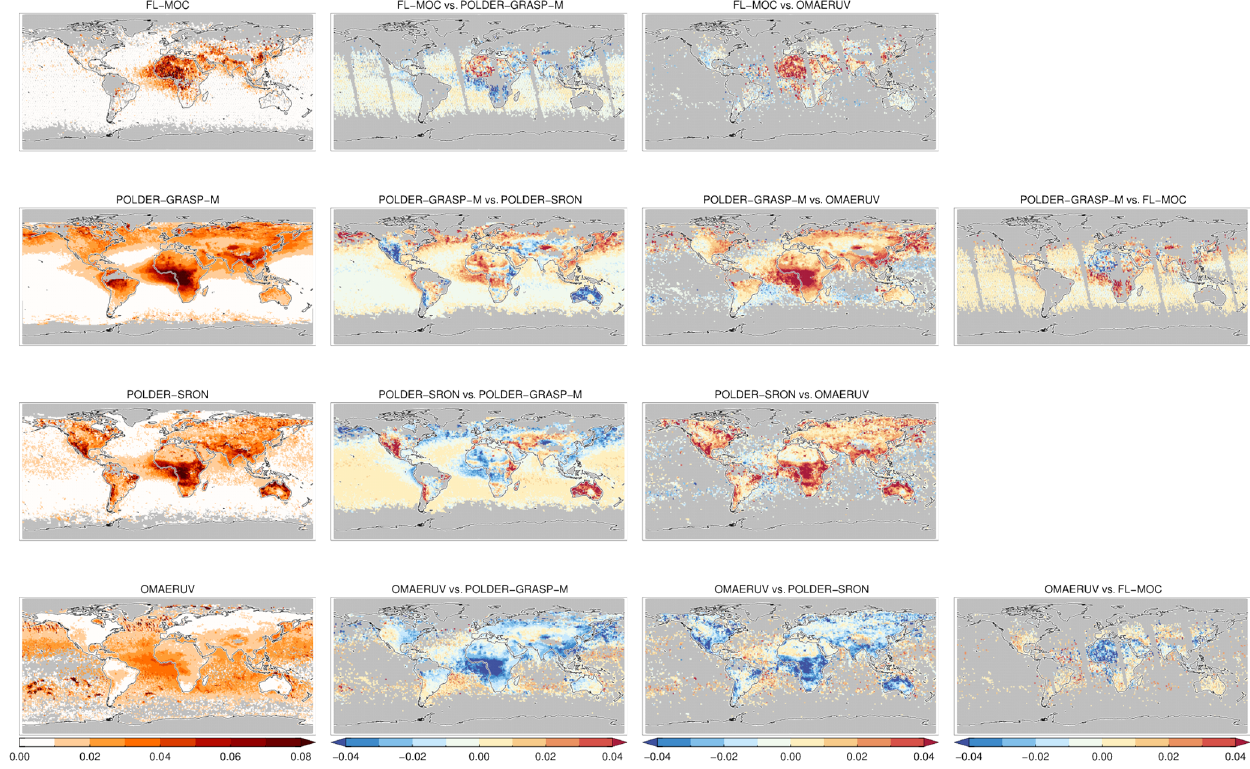
Figure 4. Global maps of AAOD for four products and their differences. AAOD differences are based on collocated data (within 3h). Note that the products are available for different years; e.g. POLDER-SRON and FL-MOC do not overlap. No minimum AOD was